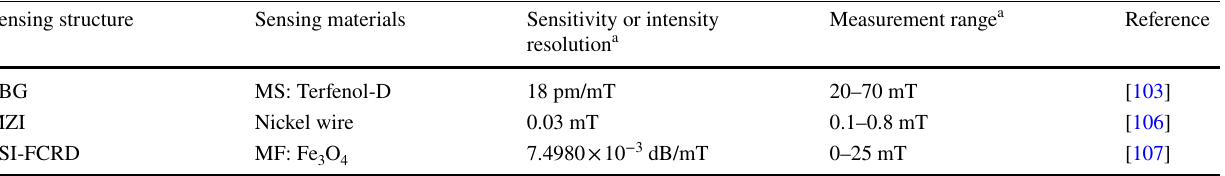
a The data units have been converted, and the conversion relationships are as follows: 1 T = 1000 mT, 1 mT = 10 Gs, 1 mT = 10 Oe, and 1 Oe =